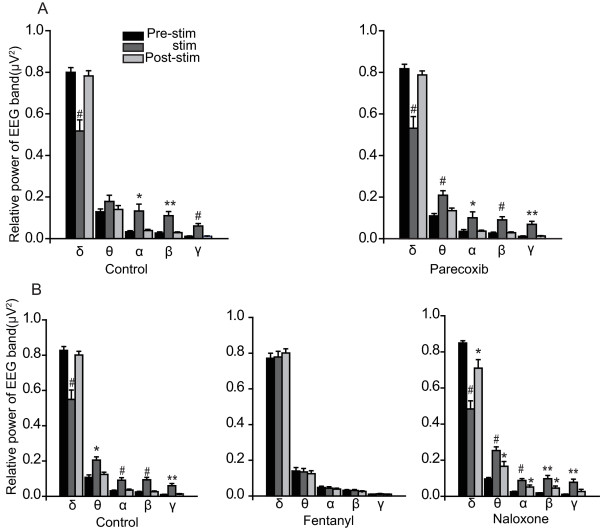
Group data for relative power of each EEG band recorded from the ACC. δ band power was decreased while other band powers were increased in response to nociceptive stimulation. A: Parecoxib had no effect on band power response. B: Fentanyl completely inhibited the band power response to nociceptive stimulation and naloxone reversed its effect. *P < 0.05, **P < 0.01, #P < 0.001.